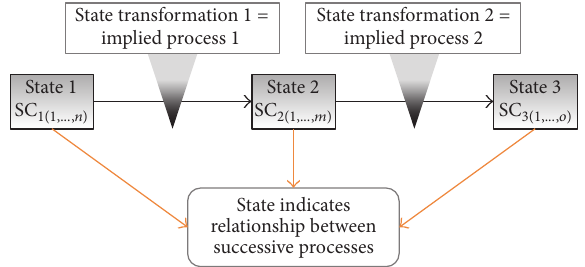
Figure 6: State indicates relationship between successive processes by